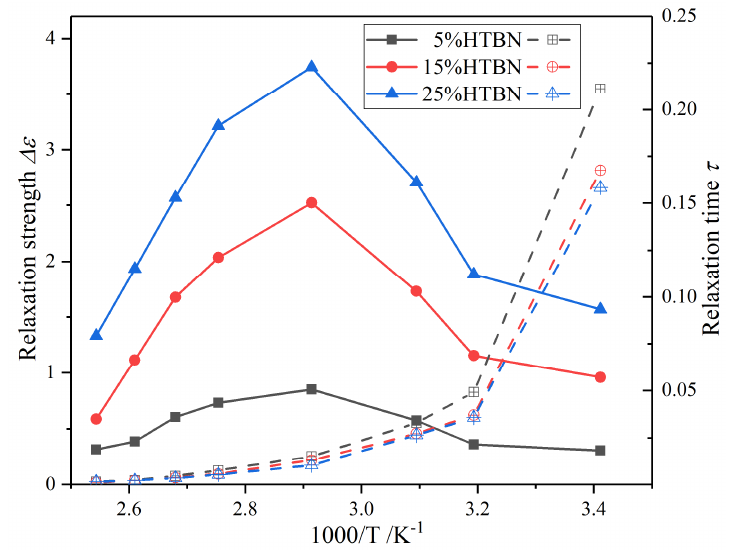
Figure 5. Havriliak‒Negami equation (HN-equation) fitting results of interfacial polarization of Figure 5. Havriliak-Negami equation (HN-equation) fitting results of interfacial polarization of samples samples with different HTBN contents. with di ff erent HTBN